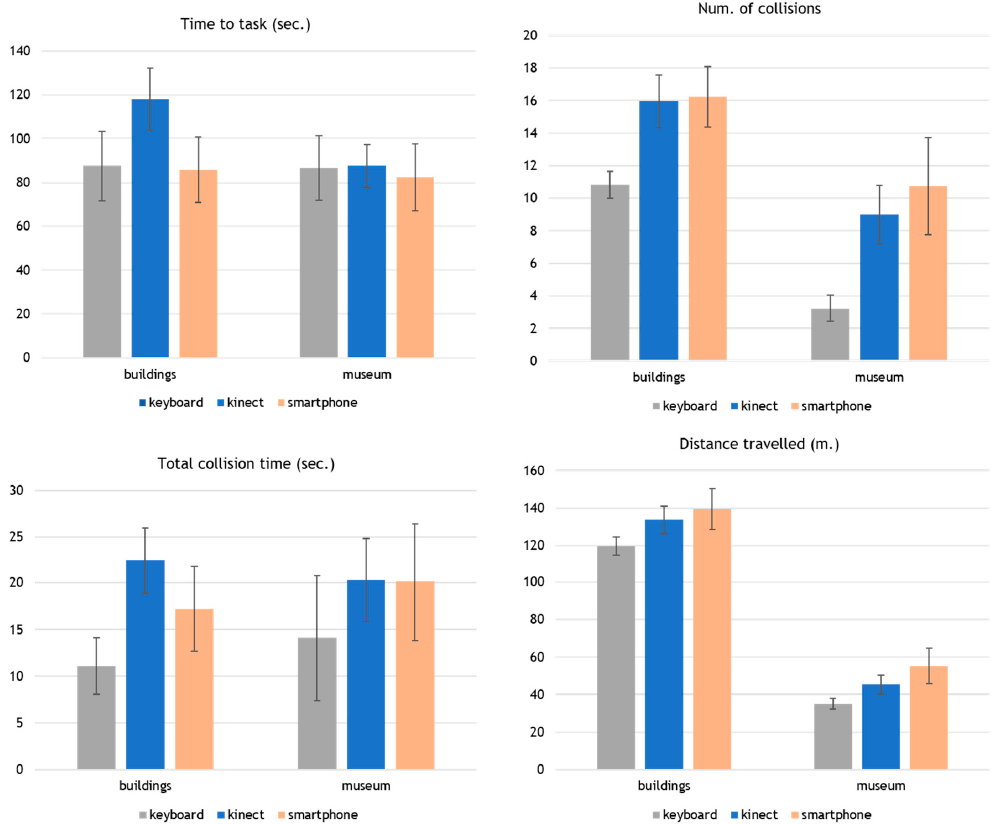
Figure 4. Mean values of the total time to finish the task in seconds (upper left), number of collisions (upper right), total collision time in seconds (lower left), and total distance travelled in meters (lower right) in the buildings and museum scenes. Error bars represent 95% confidence intervals.